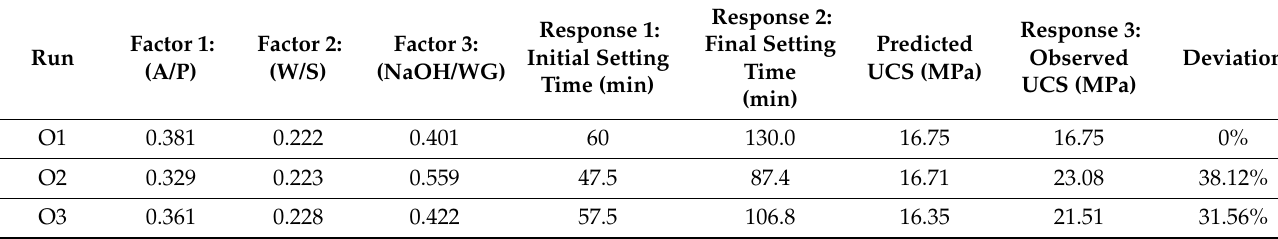
Table 12. Optimized runs for in situ